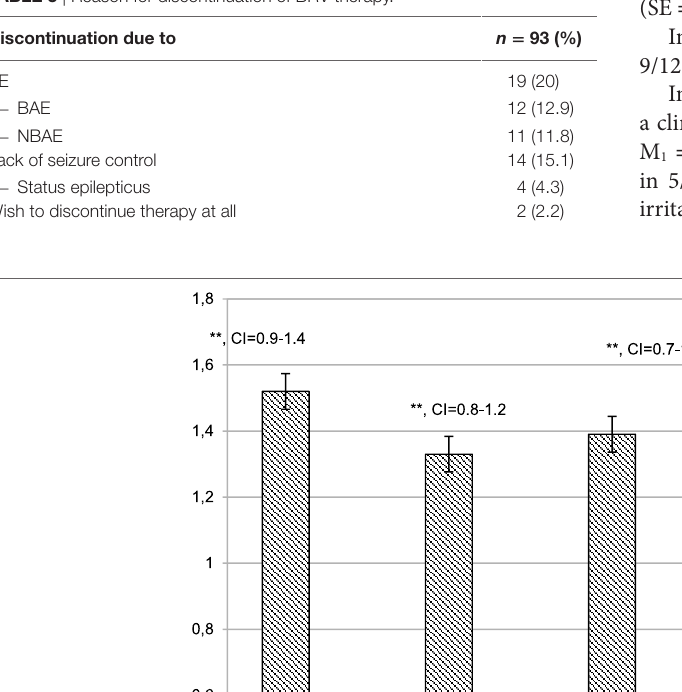
TaBle 3 | Reason for discontinuation of BRV